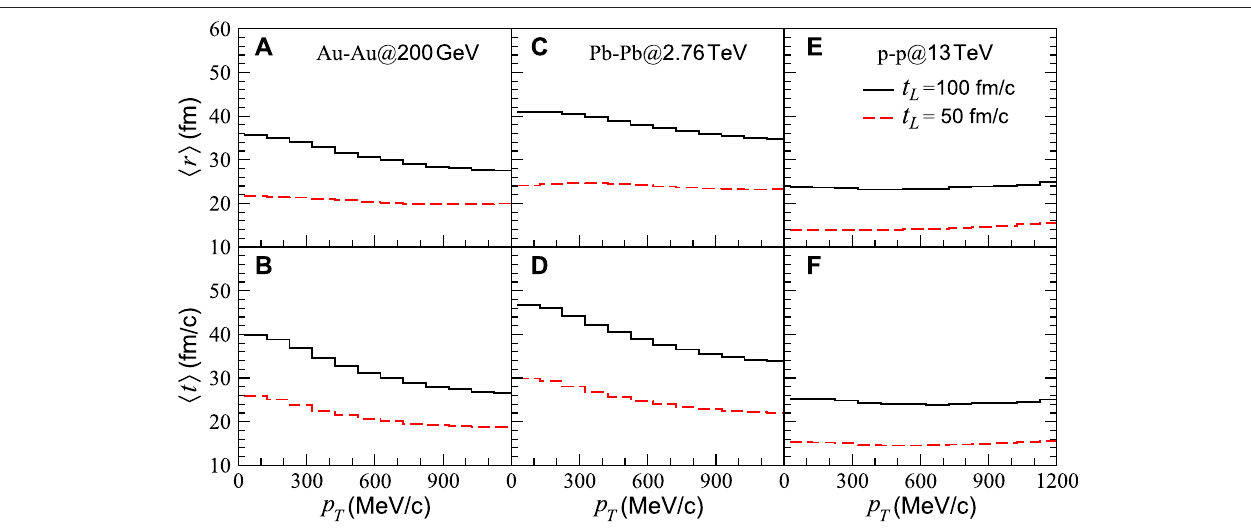
(cid:1)(cid:1)(cid:1)(cid:1) √ (cid:3) 200 GeV. (C,D) s NN (cid:1)(cid:1)(cid:1)(cid:1) √ (cid:3) 2.76 TeV. (E,F) Average spatial and temporal s NN (cid:1) √ (cid:3) 13 TeV. Solid and dashed lines denote the time limitation parameter t s L = 100 and